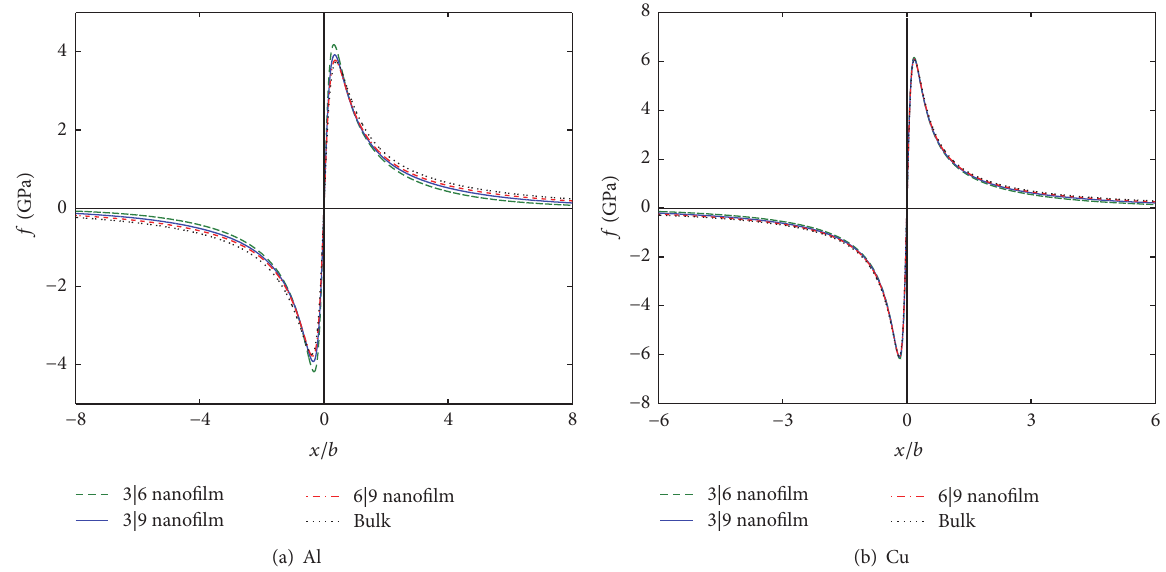
0.00.20.40.60.81.0